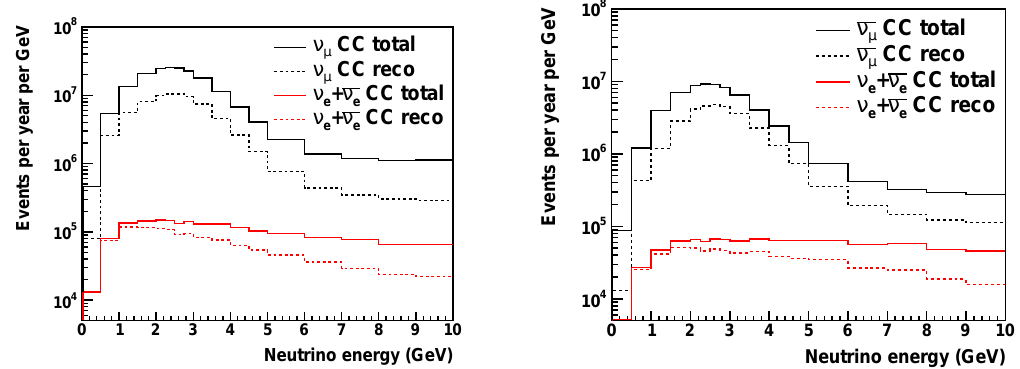
Figure 37. The rate of CC interactions in the fiducial volume of ND-LAr as a function of true neutrino energy, expressed per year of exposure assuming 1.2MW beam intensity for the LBNF beam with FHC ( left ) and RHC ( right ) beam polarity. Event rates for different final states are given in Tables 10 and 11 for FHC and RHC beam modes, respectively. The tables are based on a simulation of GENIE version